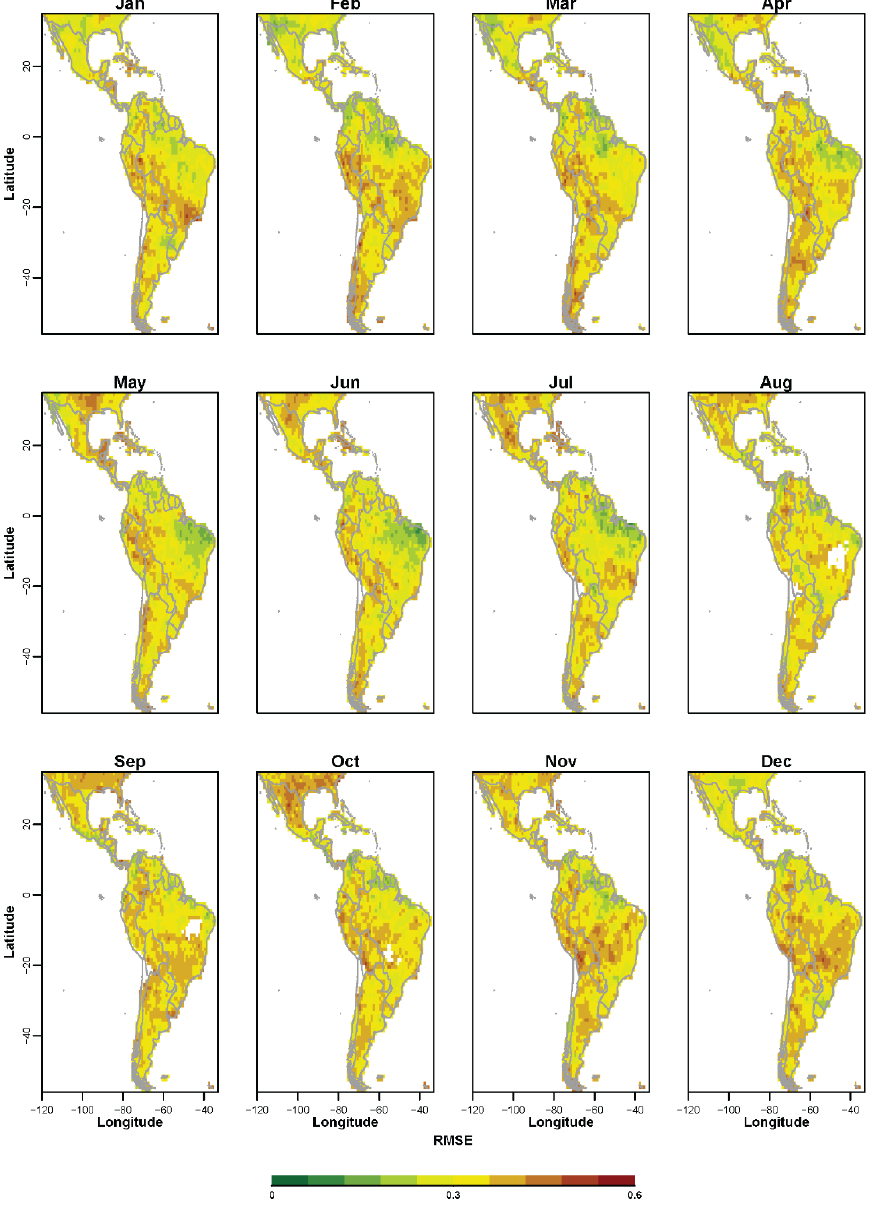
Figure 3. Root Mean Squared Error (RMSE) between the observed and forecast SPI3 at 3-month lead time (mean of the ensemble) for the hindcast period (1981–2010). Values in difference of percentile magnitude are indicated in the color bar.